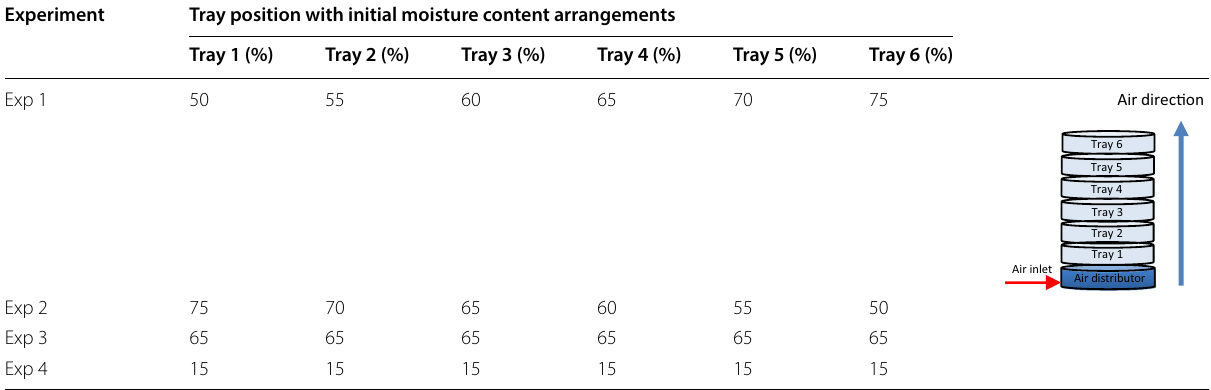
Table 1 Arrangement of initial moisture content in multi-stacked tray SSB Experiment